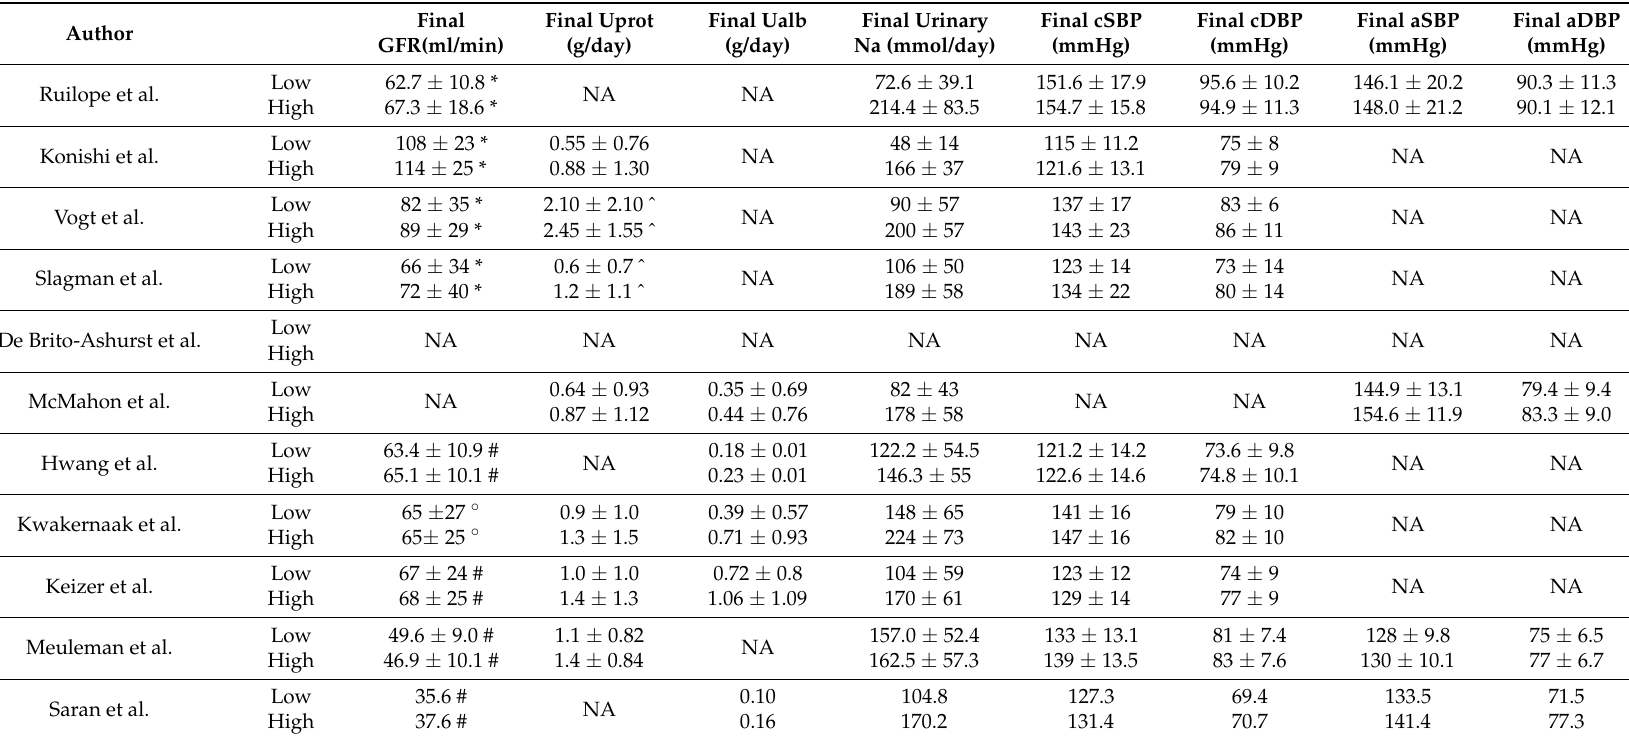
Table 2. Renal function parameters, blood pressure and urinary sodium in patients receiving low- or high-sodium